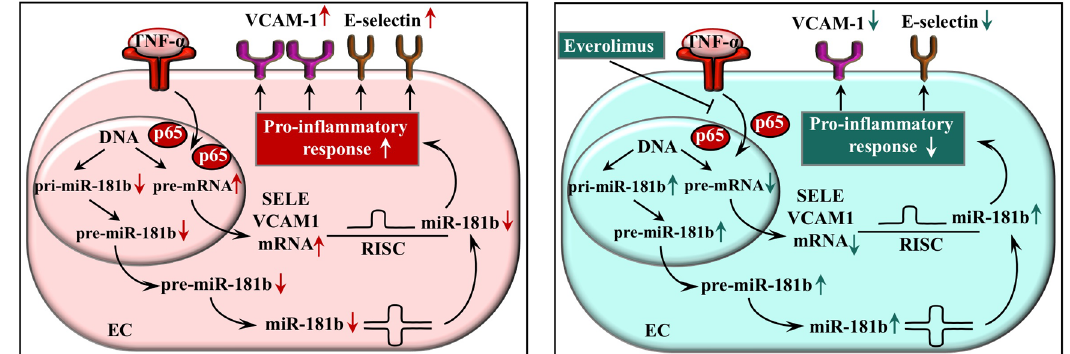
Fig 8. Schematic figure about the model to demonstrate the regulatory mechanisms of everolimus on E-selectin (SELE) and VCAM-1 expression. Everolimus decreases EC activation via suppressing the NF- κ B pathway with decreased p65 translocation into cell nuclei causing the modulation of E-selectin and VCAM-1 expression as well as miR-181b level at transcriptional and post- transcriptional level, respectively. EC: endothelial cell, TNF- α : tumor necrosis factor alpha, SELE: E-selectin, VCAM-1: vascular cell adhesion molecule-1, RISC: RNA-induced silencing